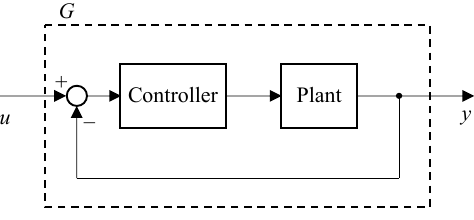
Figure 11. Block diagram of the feedback control system model for an STS system.